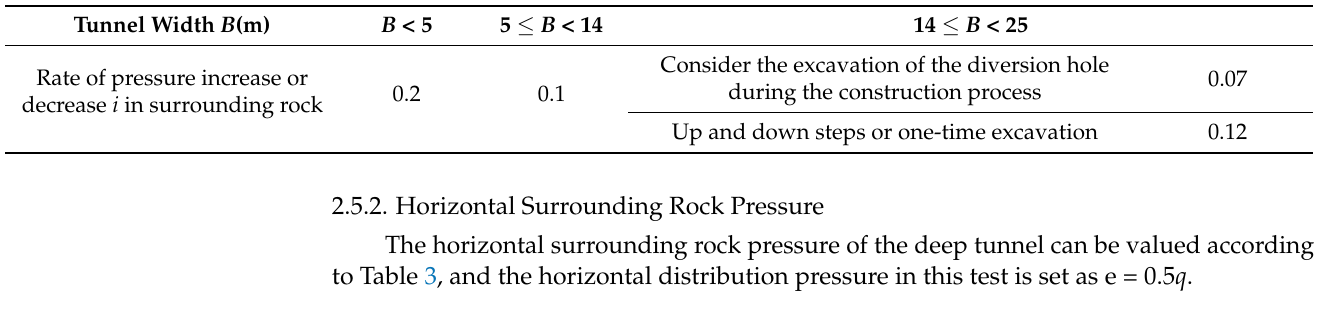
Table 2. Value of surrounding rock pressure increase and decrease rate i.